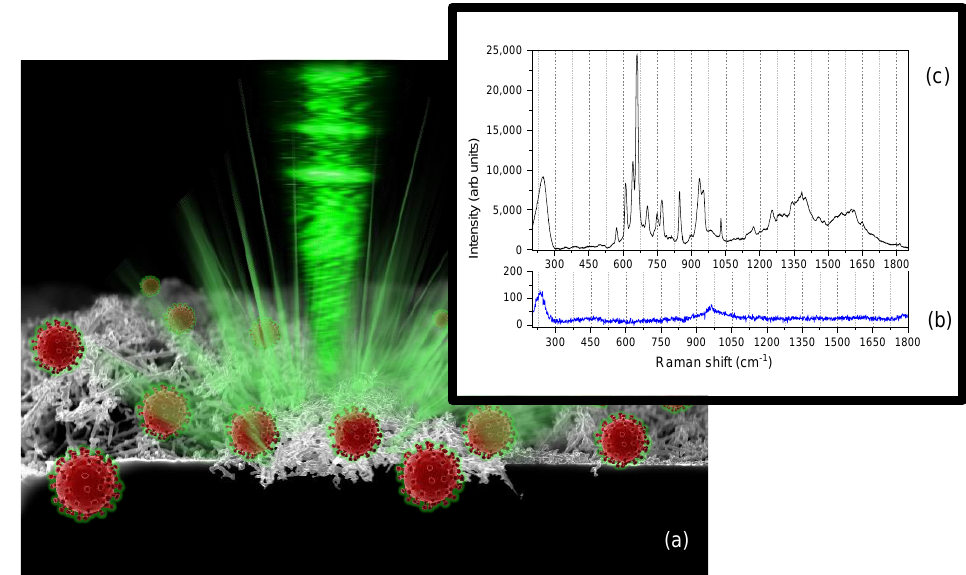
Figure 4. Sketch of the SERS experiment: a green laser is focused onto the 3D silver dendrite layer, where a drop of solution containing 0.21 nM of SARS-CoV-2 Omicron genome in RNase-free water was spotted ( a ). A strong plasmonic effect is activated due to the presence of strong electromagnetic enhancement at the nanogaps, therefore making visible the Raman spectrum of the Omicron variant in its natural habitat. ( b ) SERS spectrum of bare Ag dendrites. ( c ) SERS spectrum of the Omicron variant of the SARS-CoV-2.